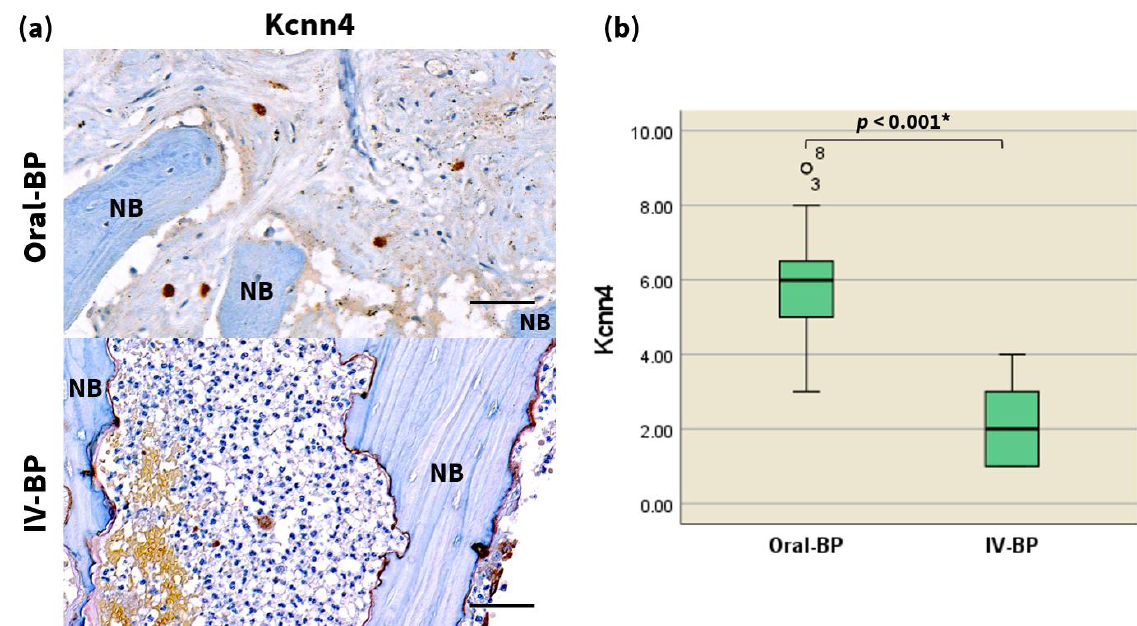
Figure 3. Kcnn4 expression is decreased in the necrotic bones of IV BP-induced advanced-stage MRONJ patients. ( a ) High-magnification images (400 × ) of the immunohistochemistry analysis of Kcnn4 expression in the specimens of the two patient groups as indicated. Scale bars = 50 µ m. Statistical analysis of the number of Kcnn4-positive cells ( b ), via the Mann–Whitney U test ( n = 20 per group). ◦ marks statistical outliers. For detailed data, see Table 2. * p <